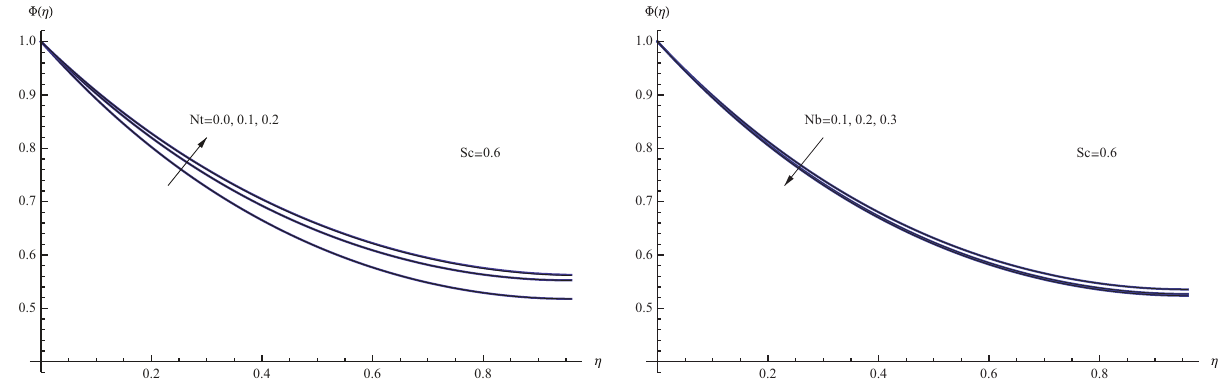
Figure 17: ( ) ϕ η for assorted quantities of Nt.